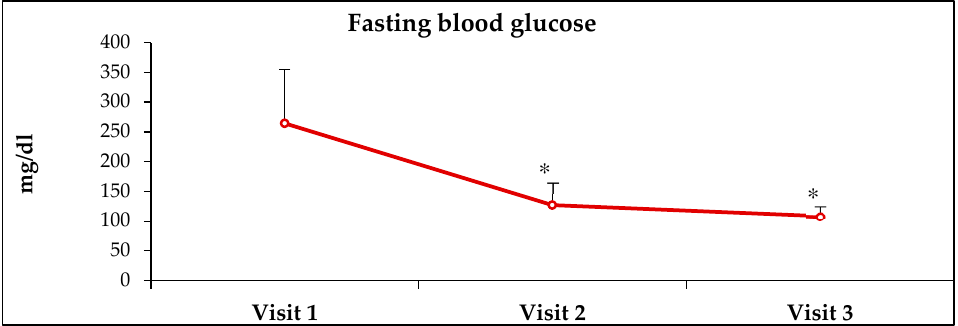
Figure 2. Improvement in estimated average glucose after receiving ABCDE. Visit-1 = first visit where ABCDE was provided; Visit-2 and Visit-3 = visits 3- and 6 months after Visit 1. ∗ = p < 0.00001.